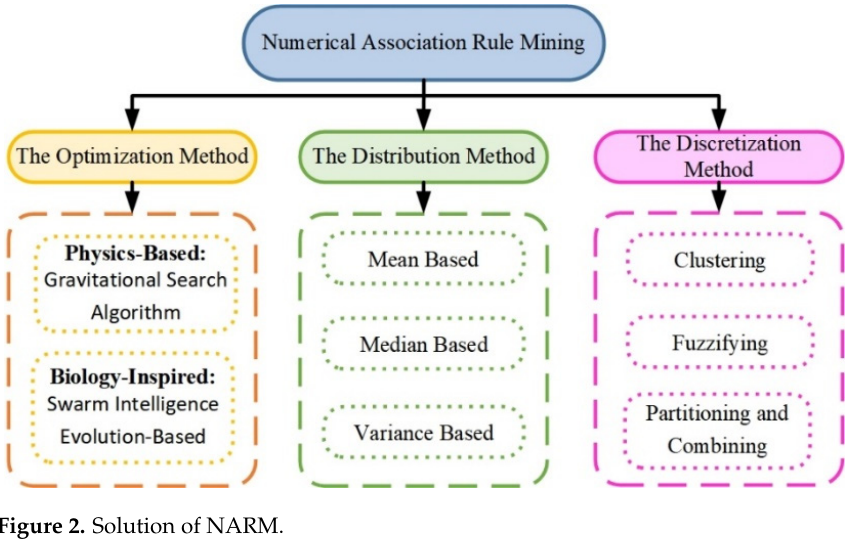
Figure 2. Solution of